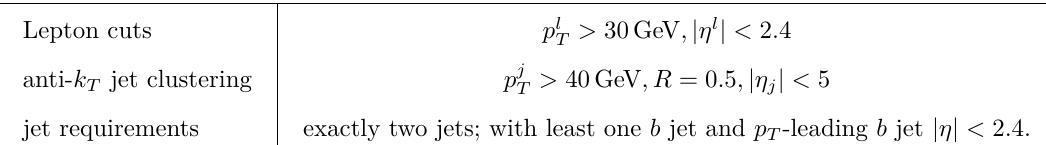
Table 5 . Kinematical cuts at mass is 173 . 3 GeV